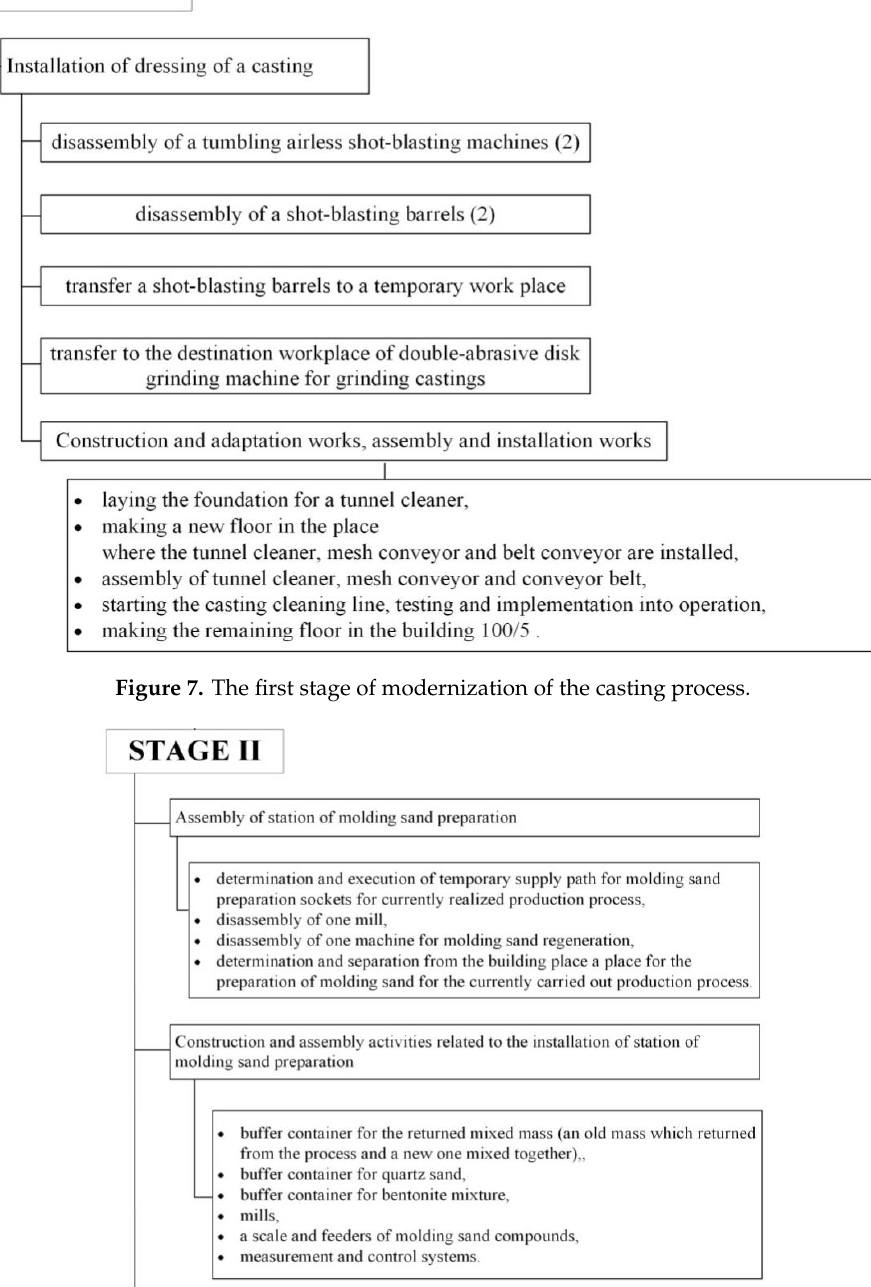
Figure 6. Schedule of modernization of the casting process.